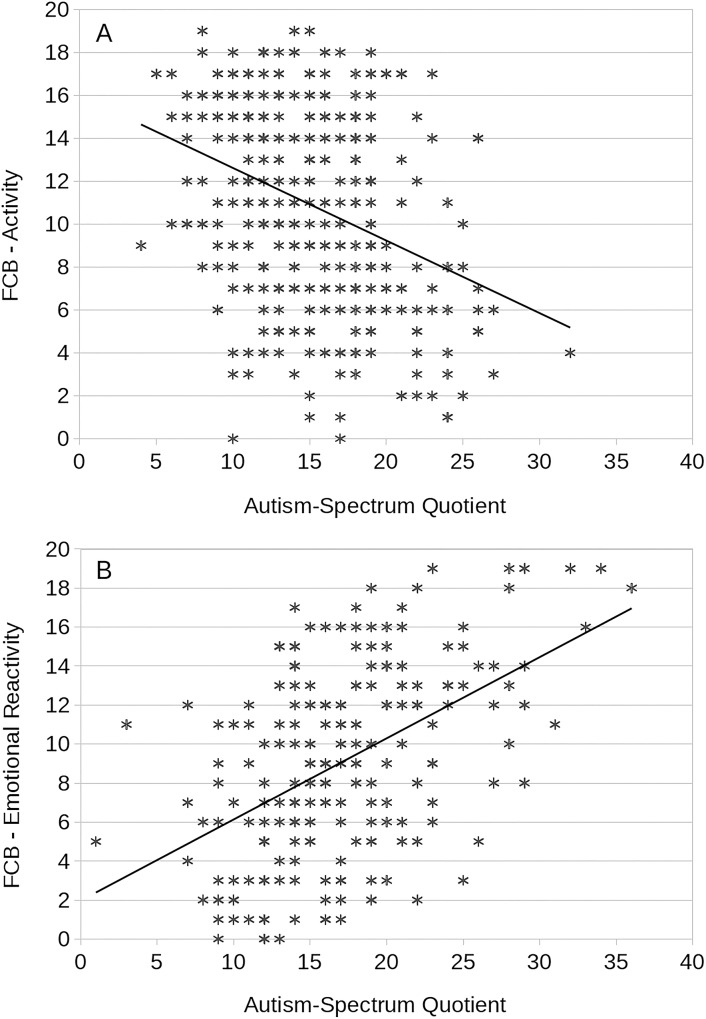
The correlation plots shown for the strongest coefficient values in group of A—females, B-males.